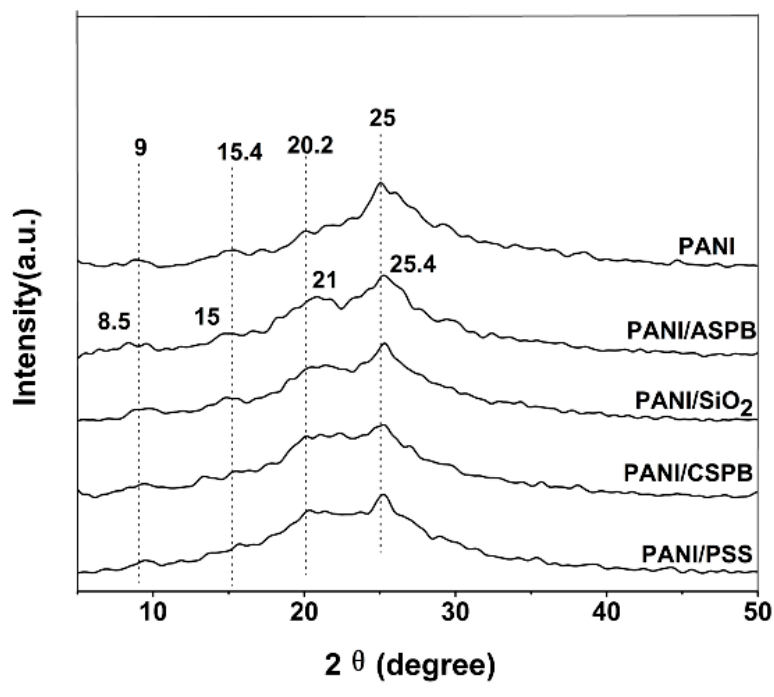
Figure 4. XRD patterns of PANI, PANI/ASPB, PANI/PSS, PANI/CSPB, and PANI/SiO 2